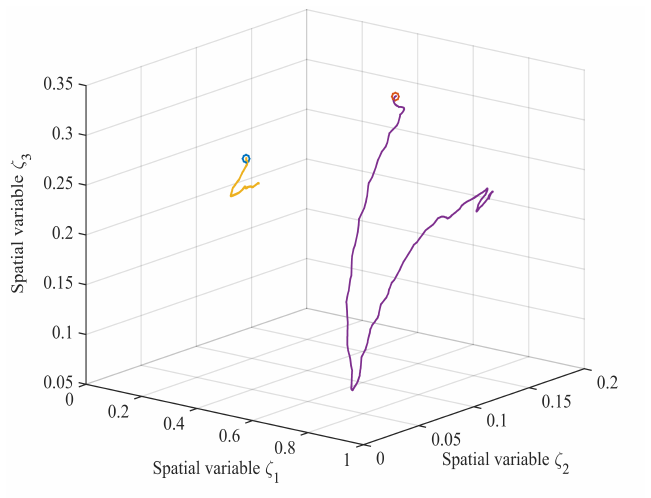
Figure 9. Moving sensing device trajectory.